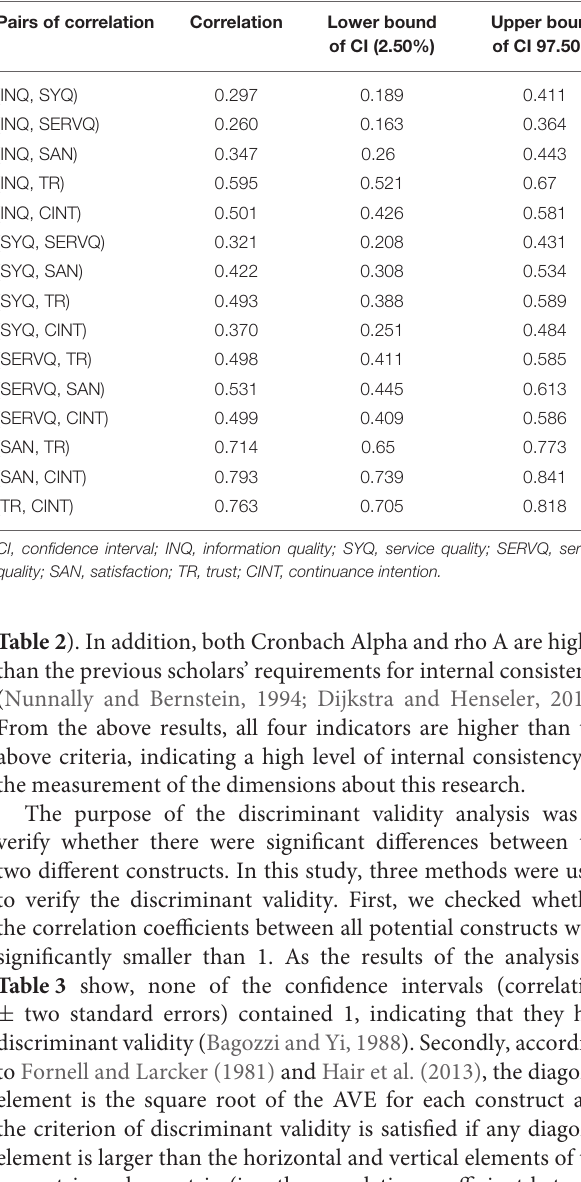
TABLE 5 | Factor loadings and cross